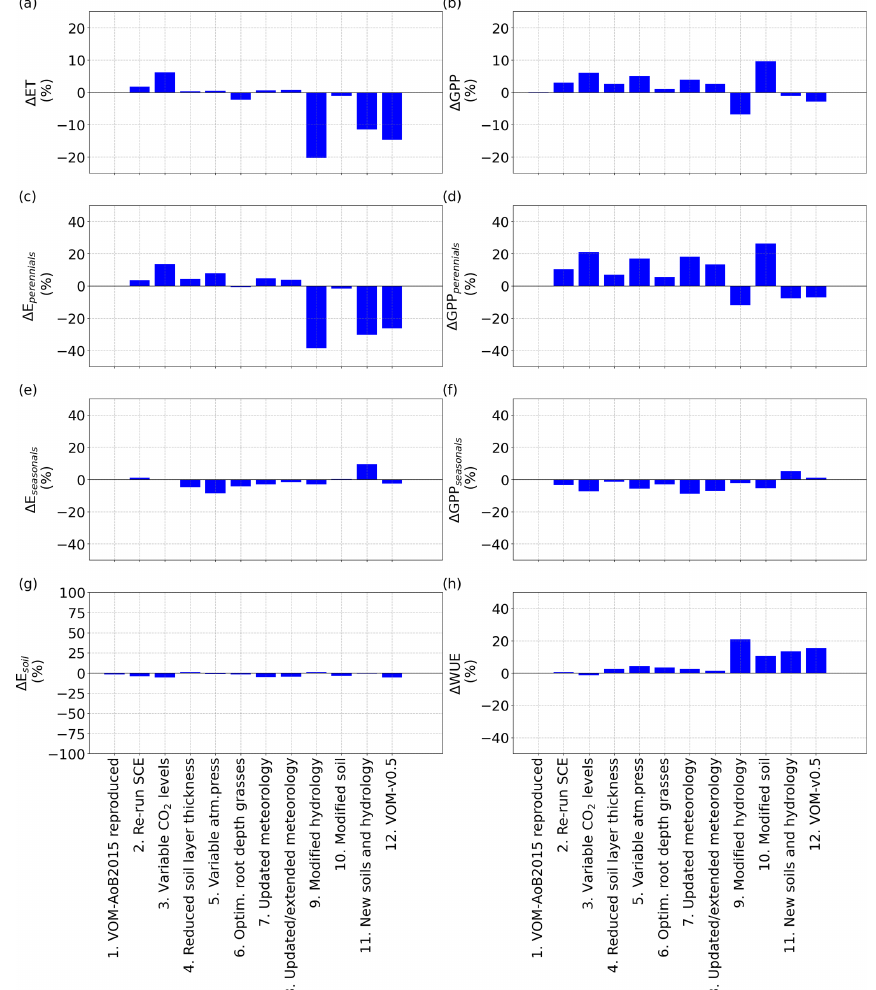
Figure 3. Relative changes in the mean annual values of the fluxes for the different (incremental) changes, as described in Sect. 2.2.9, in comparison with the VOM-AoB2015, for (a) ET, (b) GPP, (c) transpiration perennials (trees), (d) GPP perennials (trees), (e) transpiration seasonals (grasses), (f) GPP seasonals (grasses), (g) soil evaporation and (h) combined water use efficiency (WUE) of seasonal and perennial